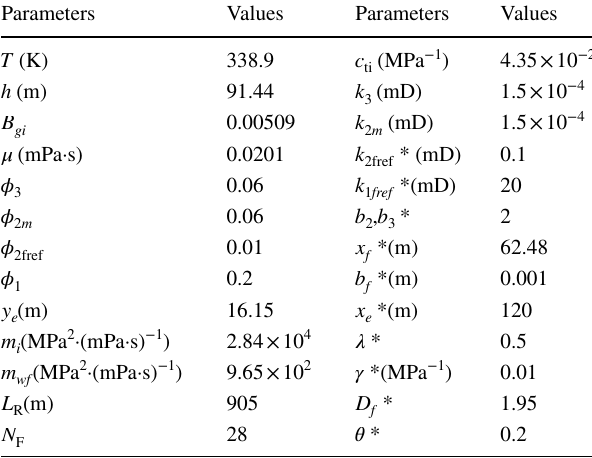
Table 2 Relevant parameters in a real tight gas reservoir